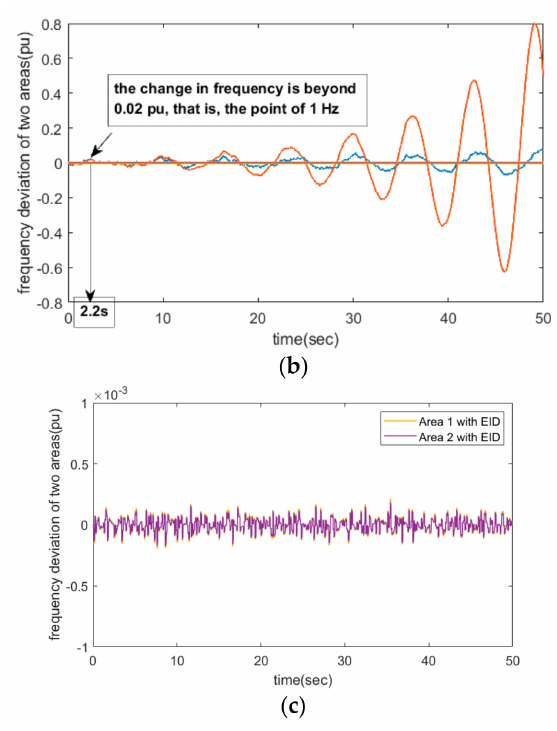
Figure 6. Dynamic response of two areas, ( a ) random load variation; ( b ) frequency response of two areas without ADRC; ( c ) frequency response of two areas with ADRC.